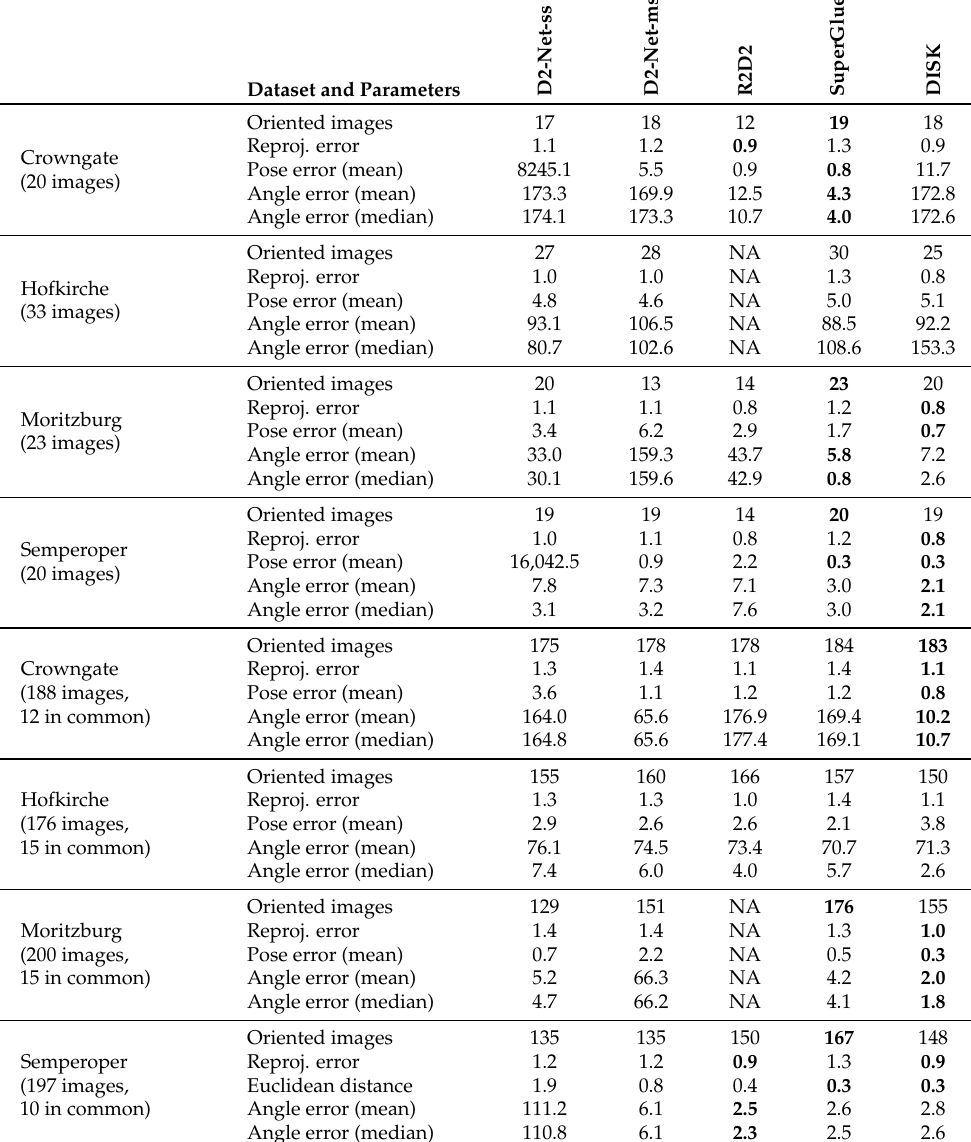
Table 3. Results of different feature matching procedures tested on eight datasets in comparison to benchmark data. Table shows respectively number of oriented images, reprojection error in pixels, Euclidean distance (scale-less) and angle error in degree. Best results are highlighted in